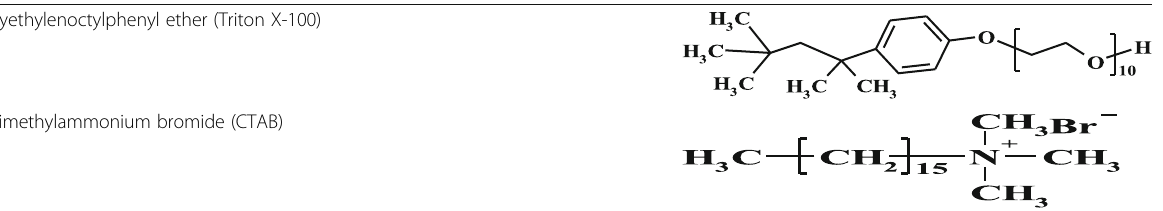
Cetyltrimethylammonium bromide